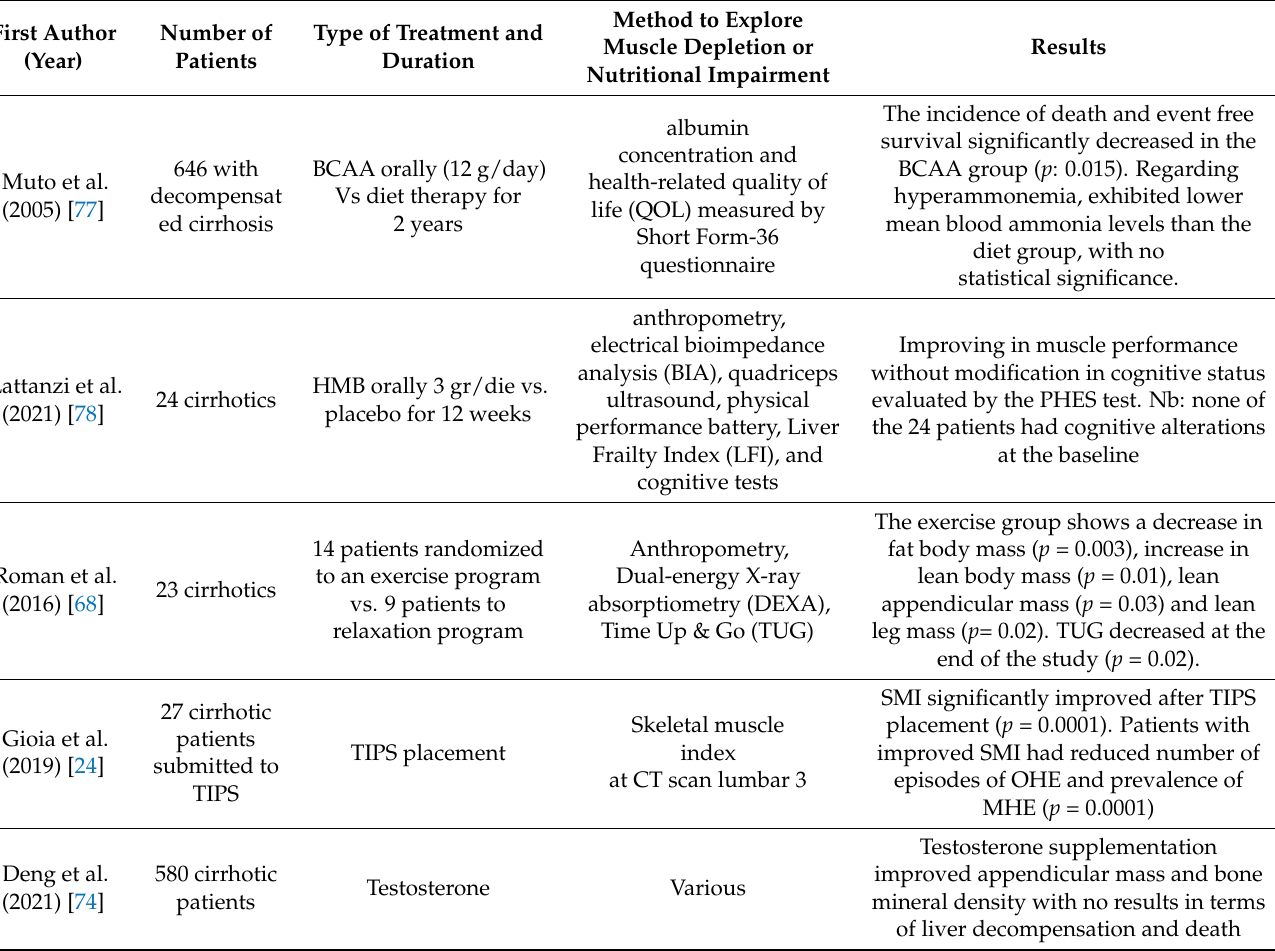
Table 2. Studies evaluating the different interventions tried for improving sarcopenia in